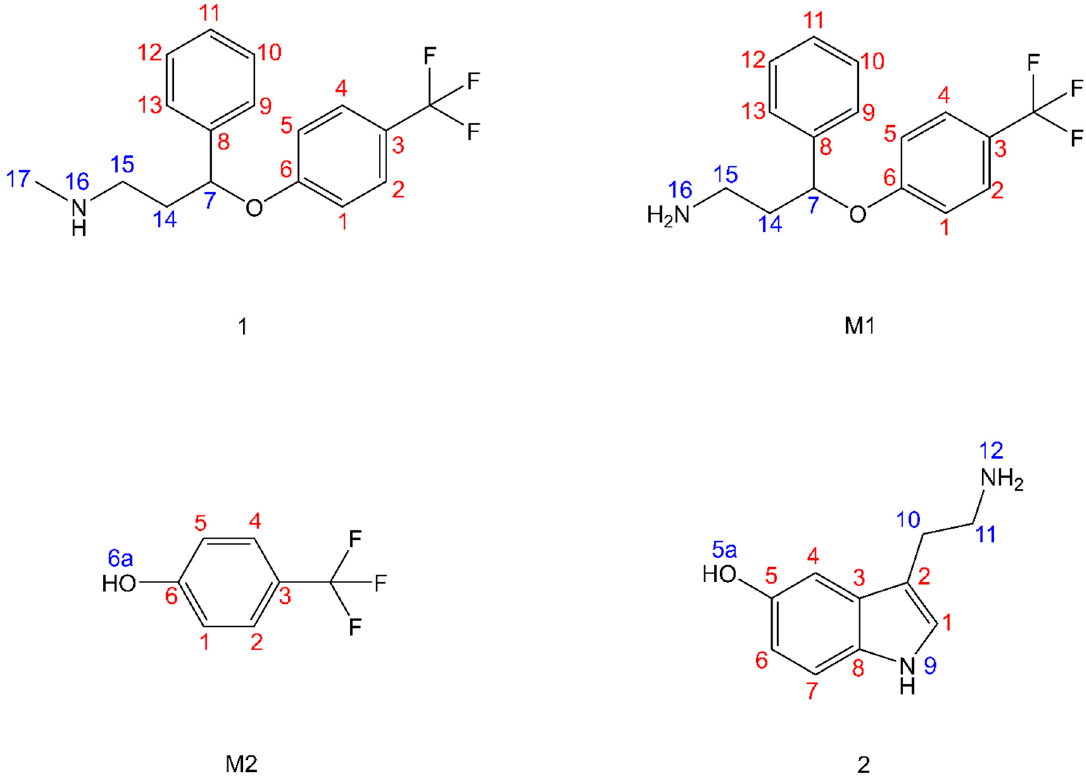
Figure 1. Fluoxetine ( 1 ) and its metabolites ( M1 and M2 ); serotonin ( 2 ).